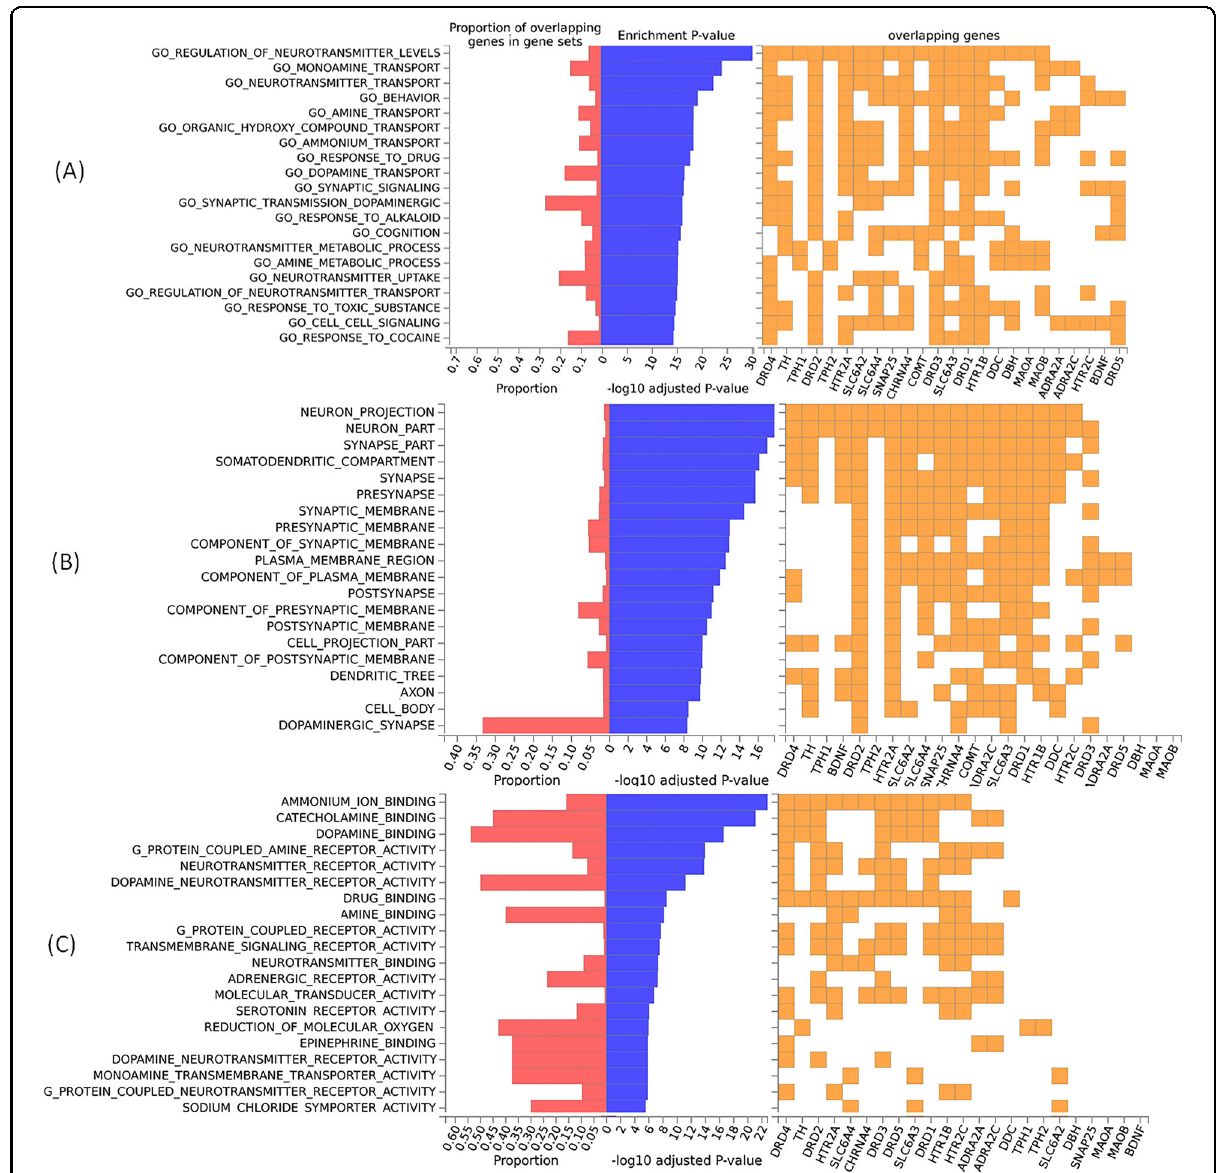
Fig. 5 Enrichment analysis of hot genes which predispose to ADHD. Summary of the top 20 gene ontology (GO) in terms of biological processes ( A ), cellular components ( B ), and molecular functions ( C ). The proportion represents the number of genes enriched in each GO category. Signi fi cant enrichment genes belong to neurotransmitters ( A ), neuron projections, part of neurons ( B ), and ammonium ion ( C ), which play a vital role in synaptic interactions suggesting the risk factor for ADHD is polymorphism in the enriched